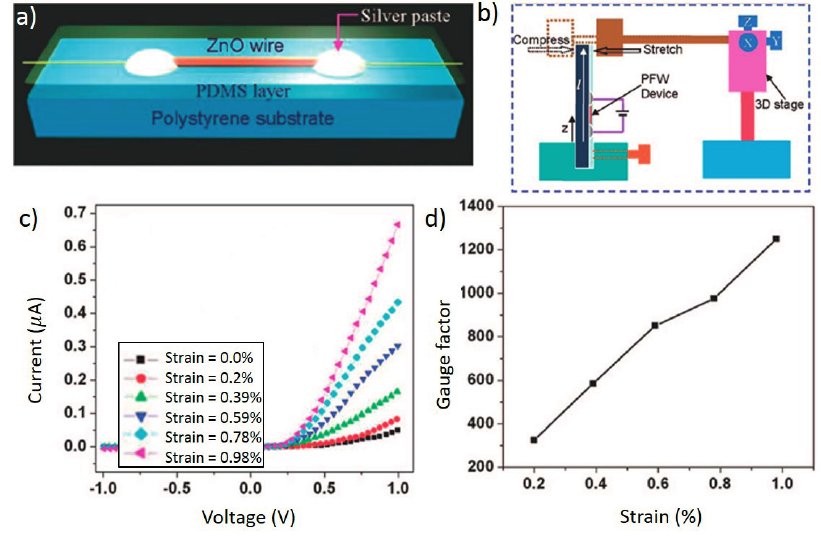
Figure 2. Concept illustration of the completed device ( a ) and strain testing setup ( b ); I-V characteristic curves for varying strains ( c ); ( d ) Gauge factor for various strains. Adapted with permission from [21]. Copyright 2008 American Chemical